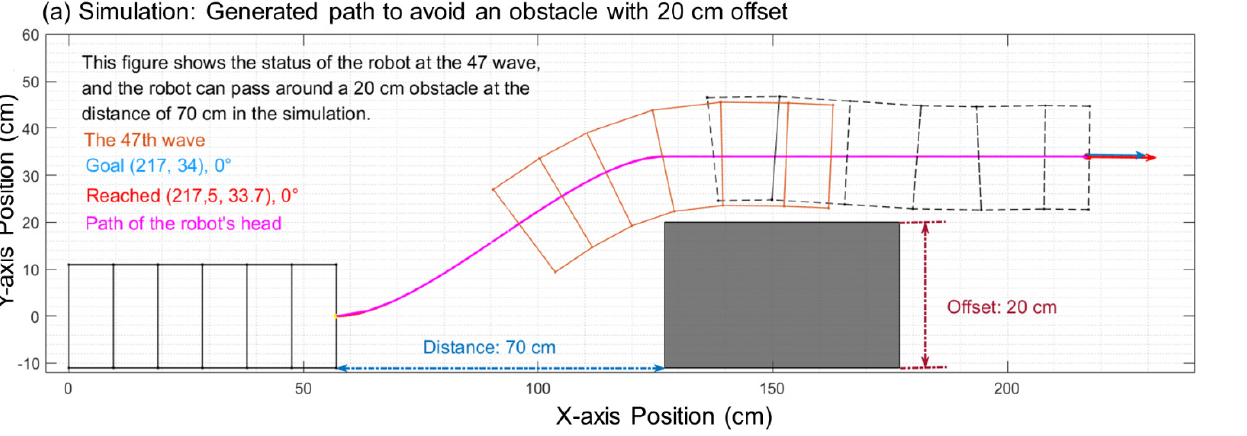
Figure 14. ( a ) simulated robot and obstacle avoidance path. The total displacement is 70 cm on the x-axis and 20 cm on the y-axis ( b ) The starting and finishing status of the physical robot with the same path implemented.